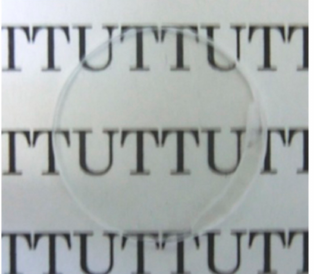
Figure 2. Photograph of the pellet obtained after being hot-pressed at 200 MPa at 170 ◦ C for 30 min.